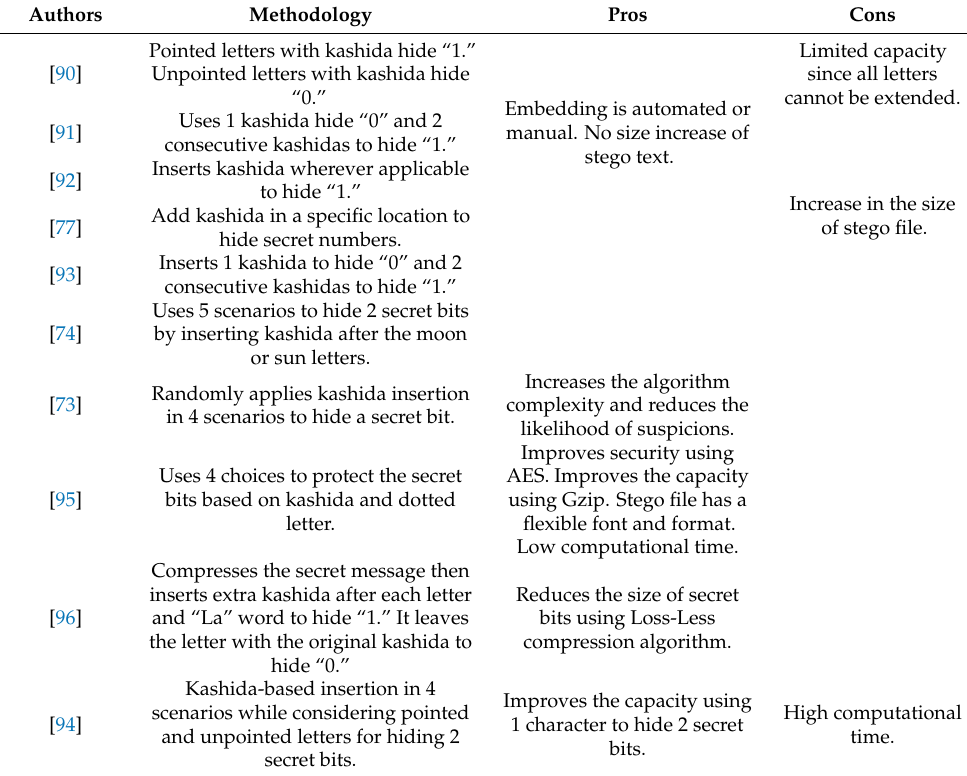
Table 12. A summary of the reviewed articles on the kashida